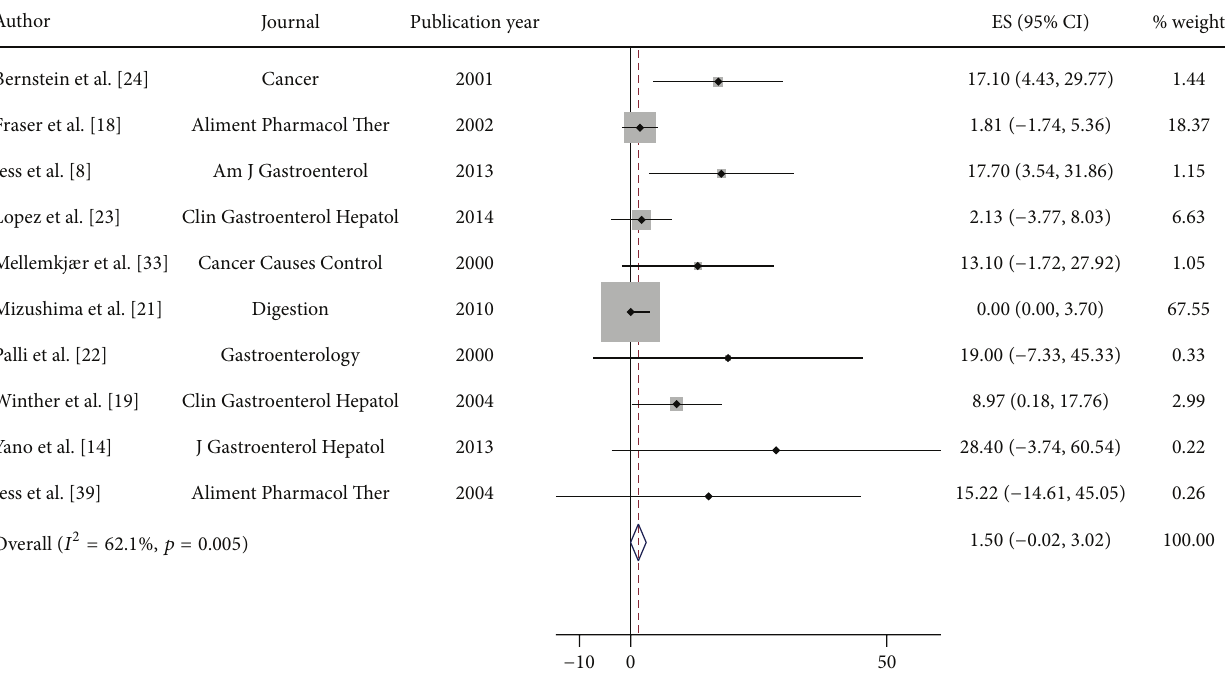
Figure 3: Incidence of leukemia in patients with inflammatory bowel disease (IBD). Each incidence estimate is presented followed by the 95% confidence intervals (CIs). Each square in the plot indicates the point estimate of the incidence. The diamond represents the summary incidence from the pooled studies. Error bars depict the 95%